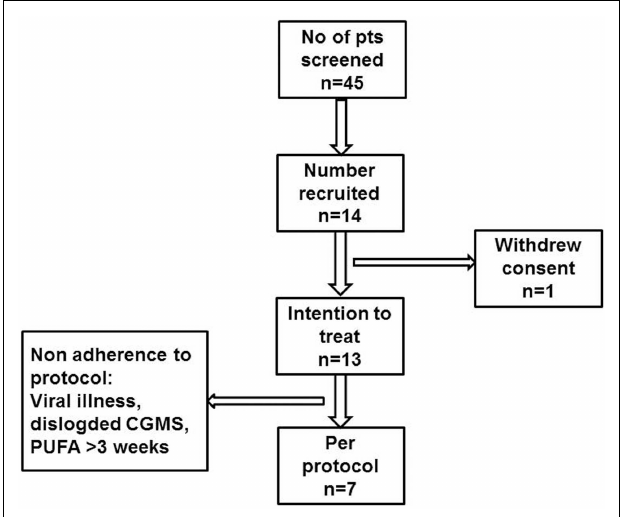
FIGURE 1 | Participant flow diagram describing patient recruitment to the PUFA pilot trial in children with CHI .